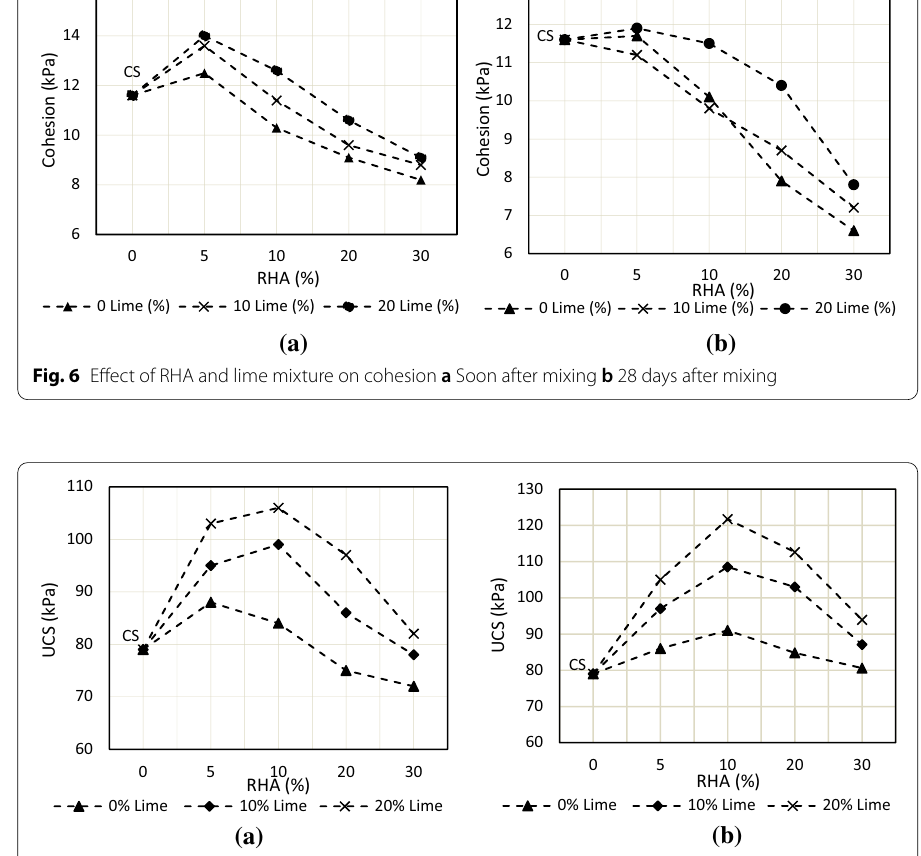
Fig. 7 Effect of RHA and lime mixture on UCS of treated soil a Soon after mixing b 28 days after